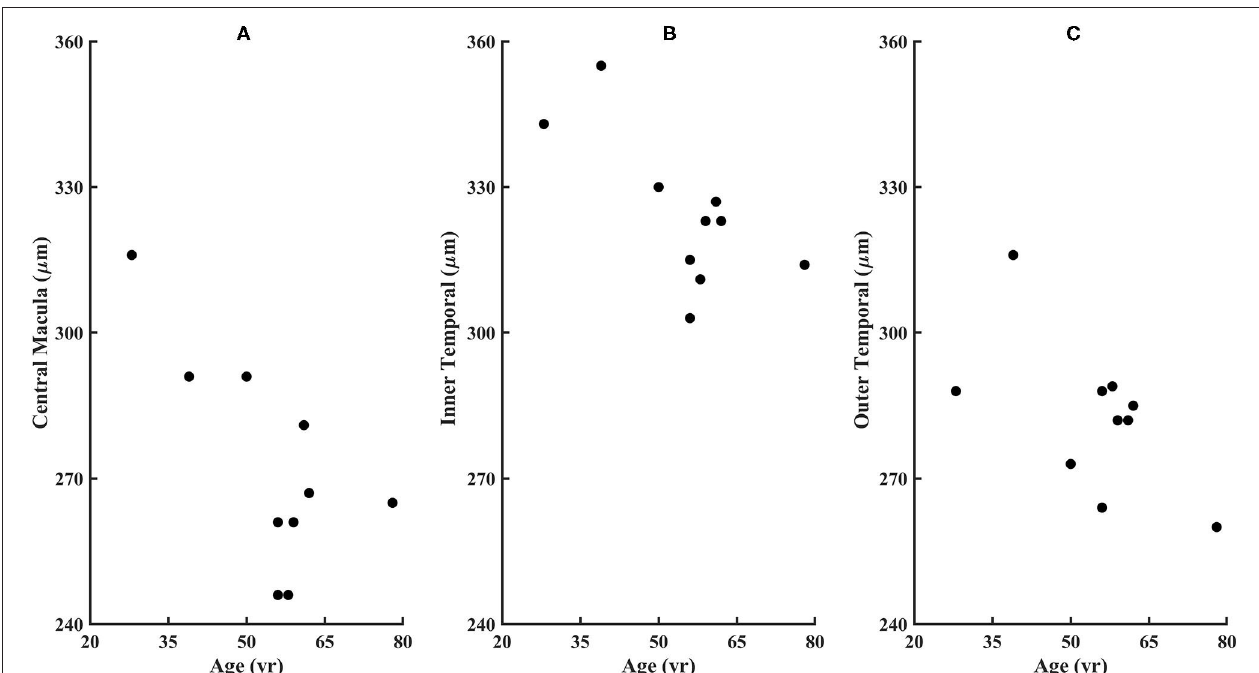
FIGURE 7 | Retinal thicknesses of the diabetic subjects from the ETDRS grid from the SD-OCT for (A) Central Macular Thickness, (B) Inner Temporal Thickness, and (C) Outer Temporal Thickness. No subject fell outside the confidence limits from the age-similar controls, although subject 209 is missing the outer nasal thickness measurement due to fixation error. The Total Retinal Thickness is significantly correlated with age for the diabetic subjects, with P < 0.02, 0.02, and 0.05 for the Central Macular Thickness, Inner Temporal Thickness, and Outer Temporal Thickness.